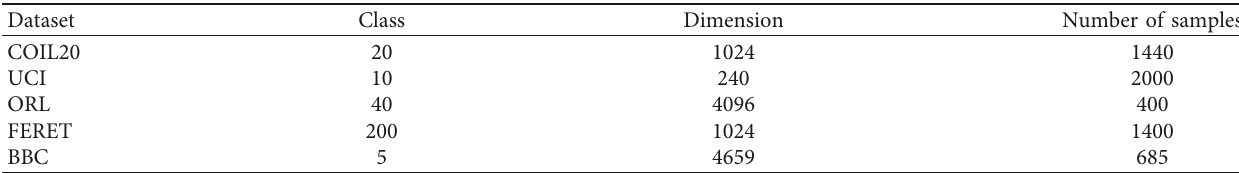
Table 1: Summary of the datasets.